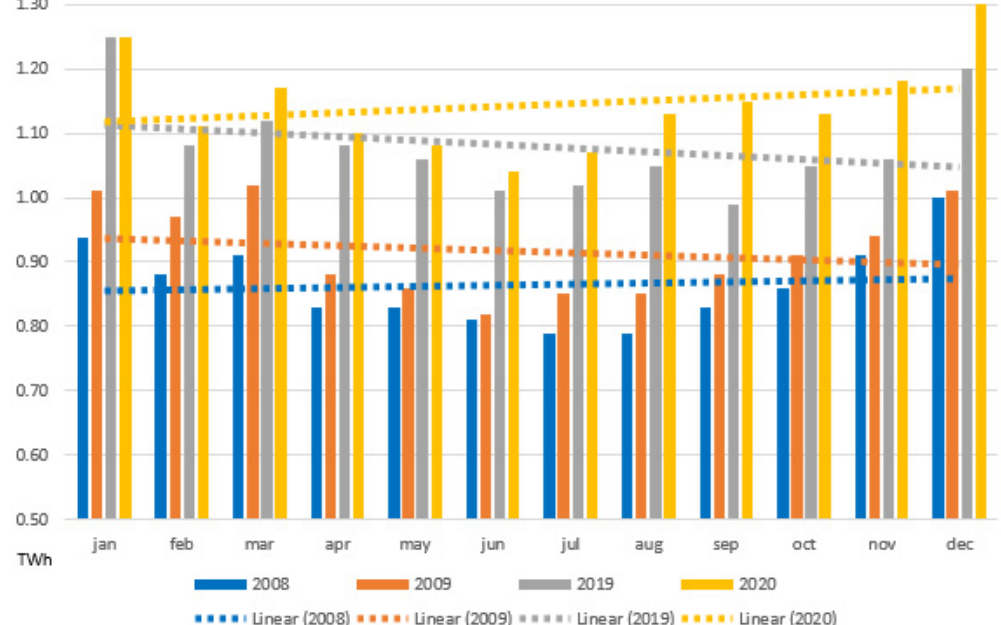
Figure 8. Comparative evolution of monthly household electricity consumption (HEC) during the financial crisis vs. the COVID-19 crisis.